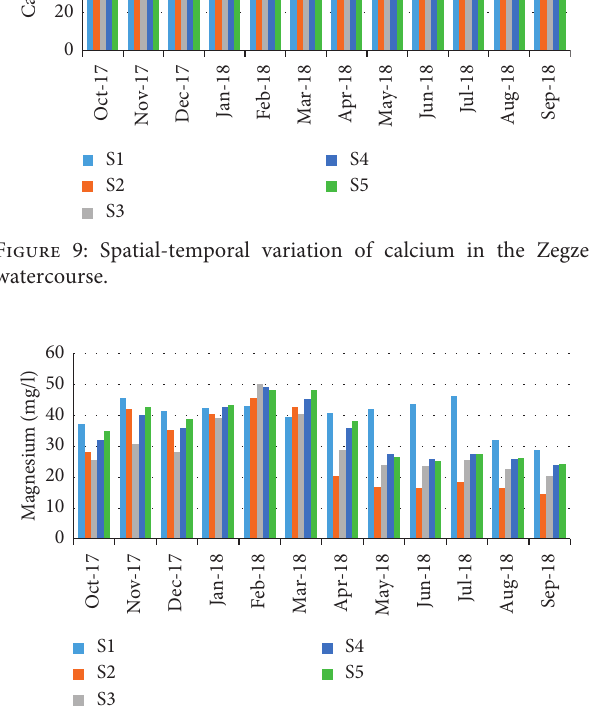
Figure 10: Spatial-temporal variation of magnesium in the Zegzel